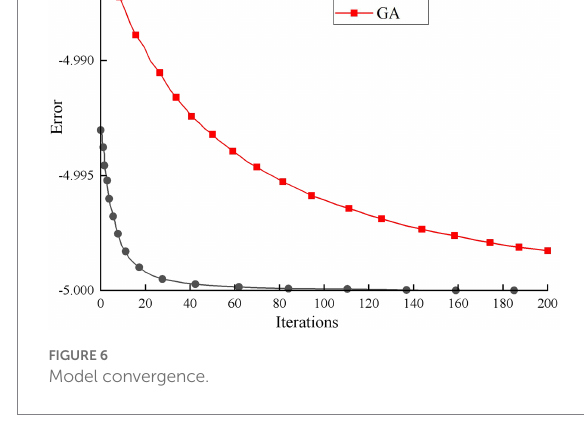
FIGURE 7 Fitness curve of the model.